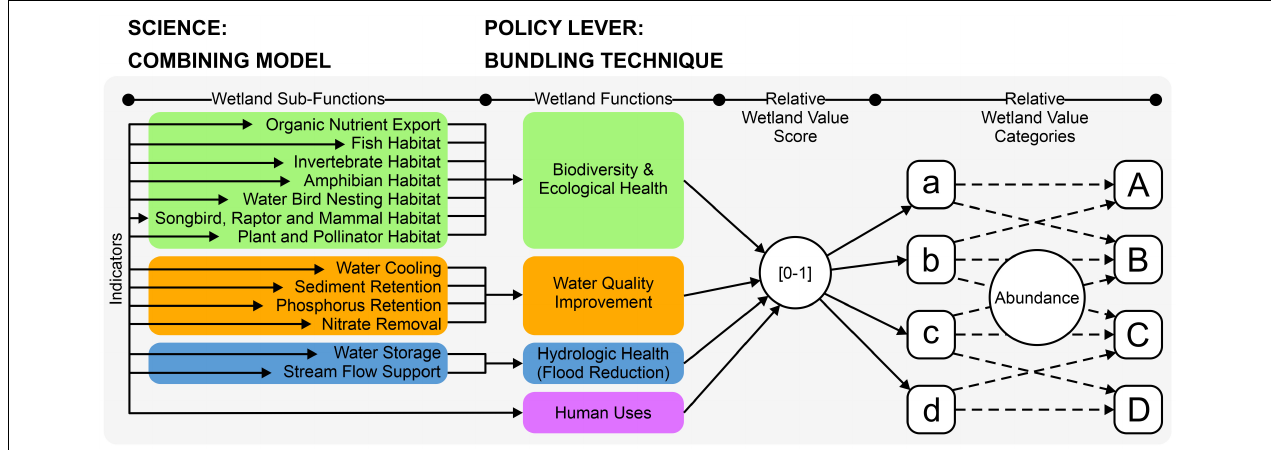
FIGURE 2 | Flowchart of Government of Alberta’s (2013) wetland policy. ABWRET-E and -A tools use scientific knowledge and data to combine indicators of wetland sub-functions into wetland function scores that are then combined into (1) four wetland value functional groups and (2) value scores that are scaled to the range of wetland value scores within each RWVAU (relative wetland value unit). Government of Alberta policy levers are used (1) to classify relative wetland value scores into unitless a-b-c-d categories in descending order of relative value, and (2) to modify relative wetland value categories upward or downward based on the abundance (i.e., historical loss or gain) of wetlands within each